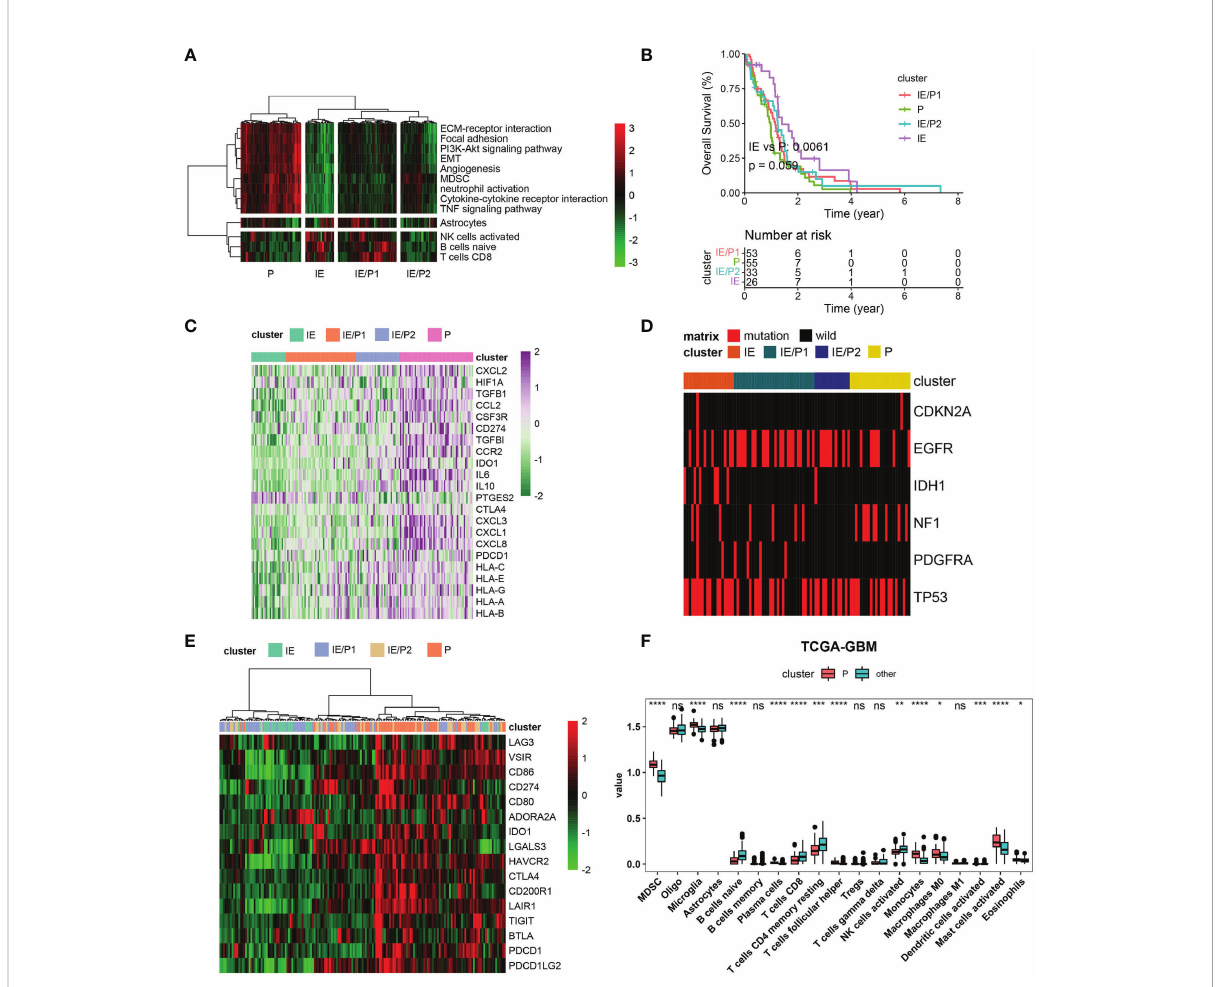
FIGURE 2 Immunosuppressive subtype identi fi cation in the TCGA – GBM cohort. (A) A heatmap of row-scaled gene signature scores from the cell deconvolution algorithm, with the color ranging from green to red, represents the activity score from low to high. The samples in this column were grouped into four TME subtypes. (B) Overall survival of patients strati fi ed by TME subtype classi fi cation. The log-rank p-value between subtypes IE and P was 0.0061, and the annova log-rank p-value for four subtypes was 0.059. (C) The expression pro fi le of immune suppression-related genes across four TME subtypes, with the color ranging from green to purple, represents the expression value from low to high. (D) Mutation frequency of fi ve high-frequency mutant genes across four TME subtypes. Samples were shown in the column. Samples with mutations were color red. (E) The expression pro fi le of inhibitory immune checkpoints across four TME subtypes. (F) Differential immune cell in fi ltration level across immunosuppressive subtypes and others. Statistical signi fi cance between groups was tested by Wilcox. *P < 0.05, **P < 0.01, ***P < 0.001, ****P < 0.0001, ns > =